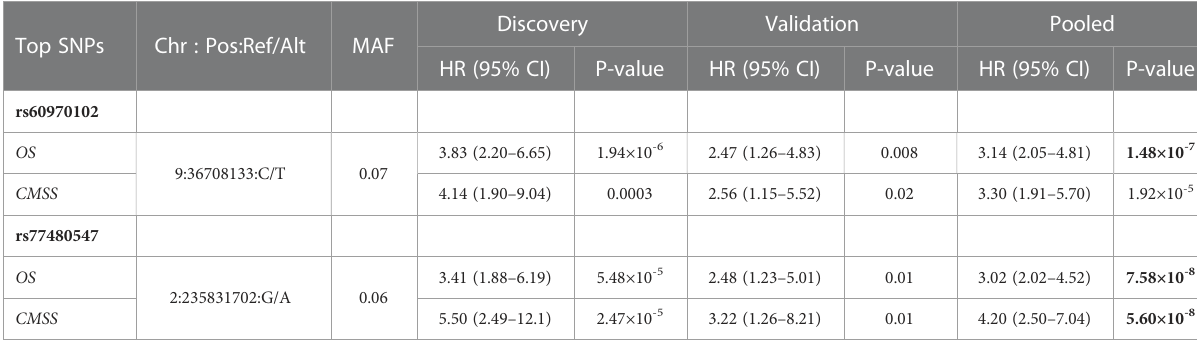
TABLE 2 The two most signi fi cant associations of germline variants with overall survival (OS) and cutaneous-melanoma speci fi c survival (CMSS) identi fi ed in a GWAS in the discovery, validation and pooled cohorts.